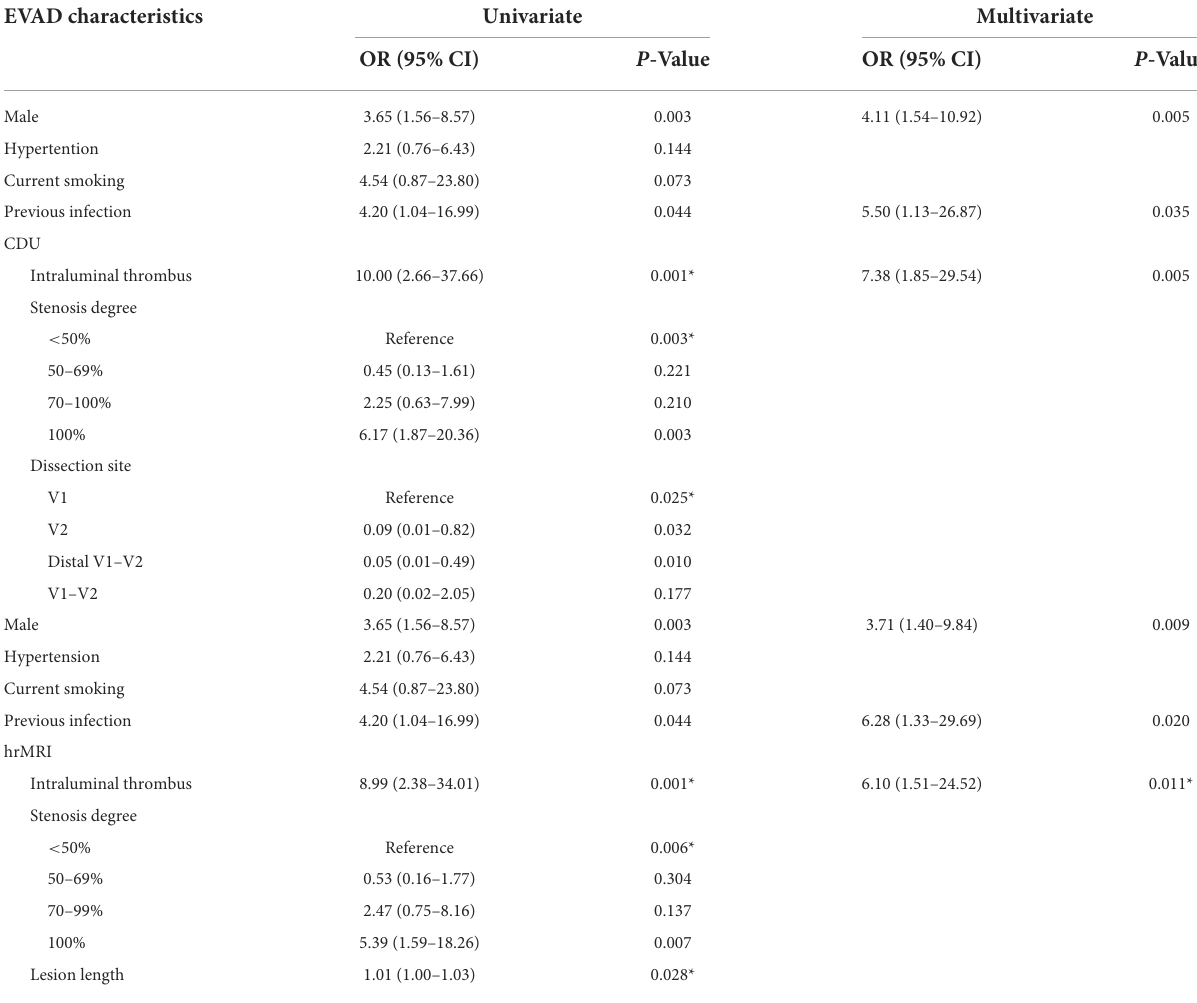
TABLE 5 Clinical predictors and characteristics of on CDU and hrMRI images in patients with EVAD correlated to ischemic events. EVAD